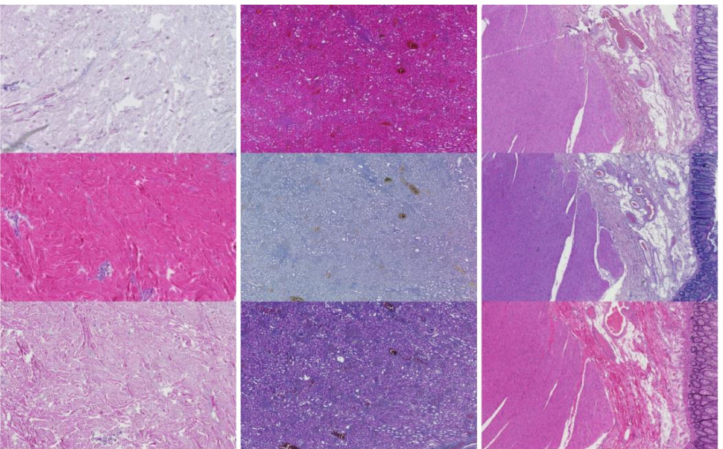
Figure 3. For illustration purposes, three ROIs from three laboratories per tissue type (column-wise). The first column is skin, the second column is kidney, and the last column is colon.